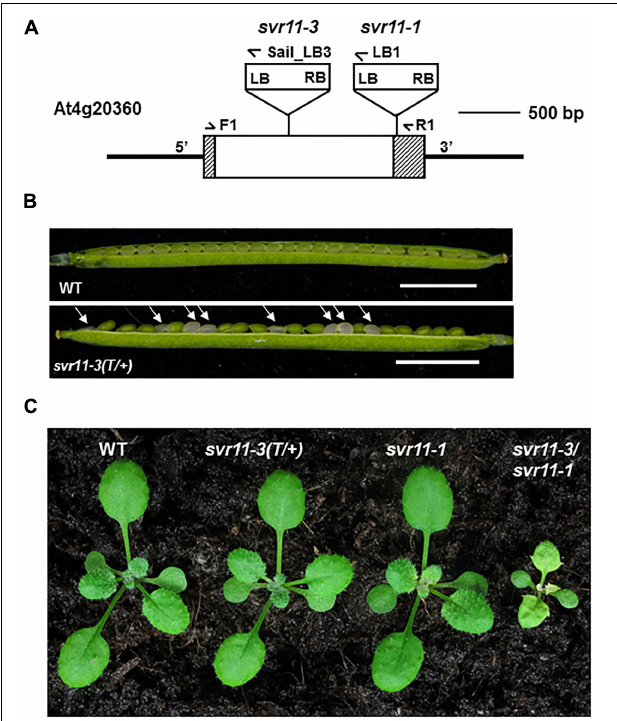
FIGURE 4 | Phenotypic characterization of the svr11 T-DNA insertion null allele mutant. (A) Identification of a null allele of SVR11, svr11-3 . (B) Developing seeds within a silique from a heterozygous svr11-3 mutant and wild-type at the same developing state. Bar stands for 2,500 µ m. (C) Representative 2-week-old wild-type, svr11-3(T/+) , svr11-1 , svr11-3/svr11-1 plants.